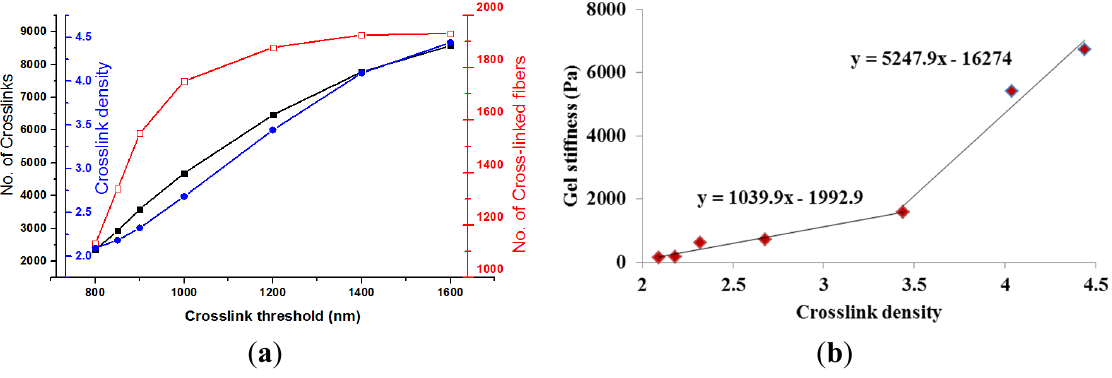
Figure 4. ( a ) Crosslink threshold regulated microstructure changes of collagen gel; ( b ) Correlation between crosslink density and gel